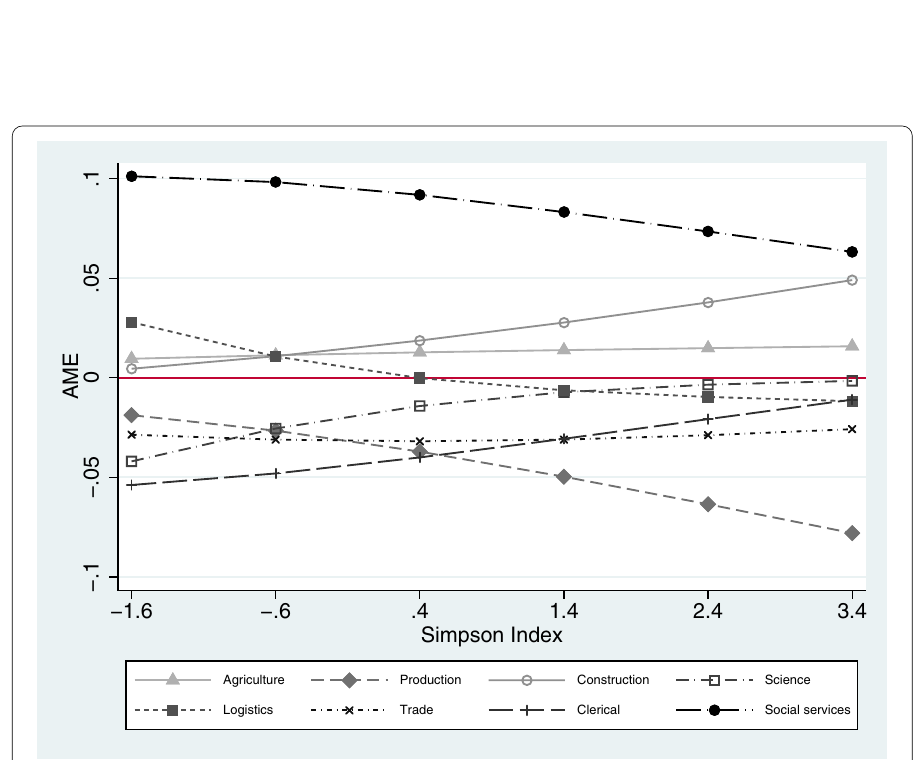
Fig. 8 Interaction of social orientation with the diversity index. Data source: NEPS, SC4, estimation see Table